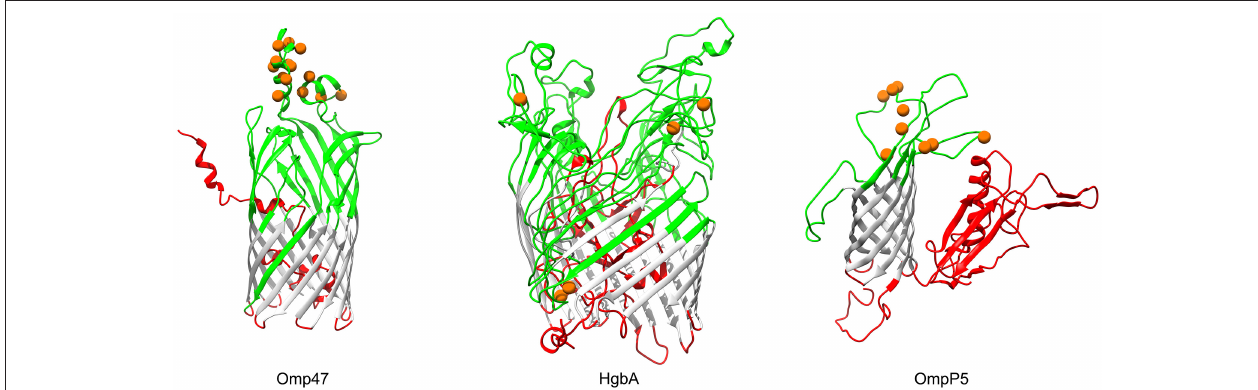
FIGURE 5 | Three-dimensional structural models of β -barrel outer membrane proteins. Topology of three outer membrane proteins undergoing positive selection are color-coded according to the BOCTOPUS2 predictions (Hayat et al., 2016): red for inner-loops, gray for transmembrane β -strands, and green for outer-loops. Orange spheres stand for amino acid residues that are subject to strong positive selection (posterior probability > 95%).